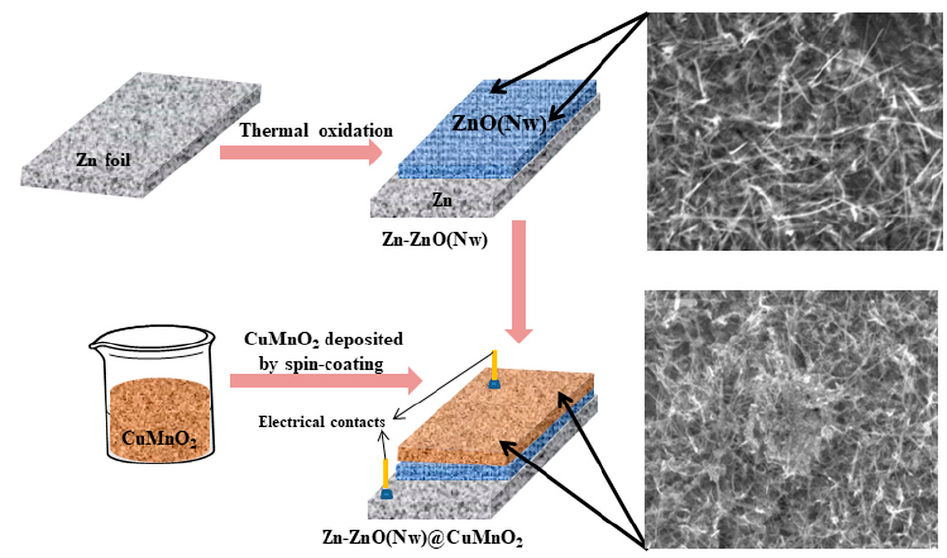
Figure 1. Schematic illustration of the gas sensor achievement process.